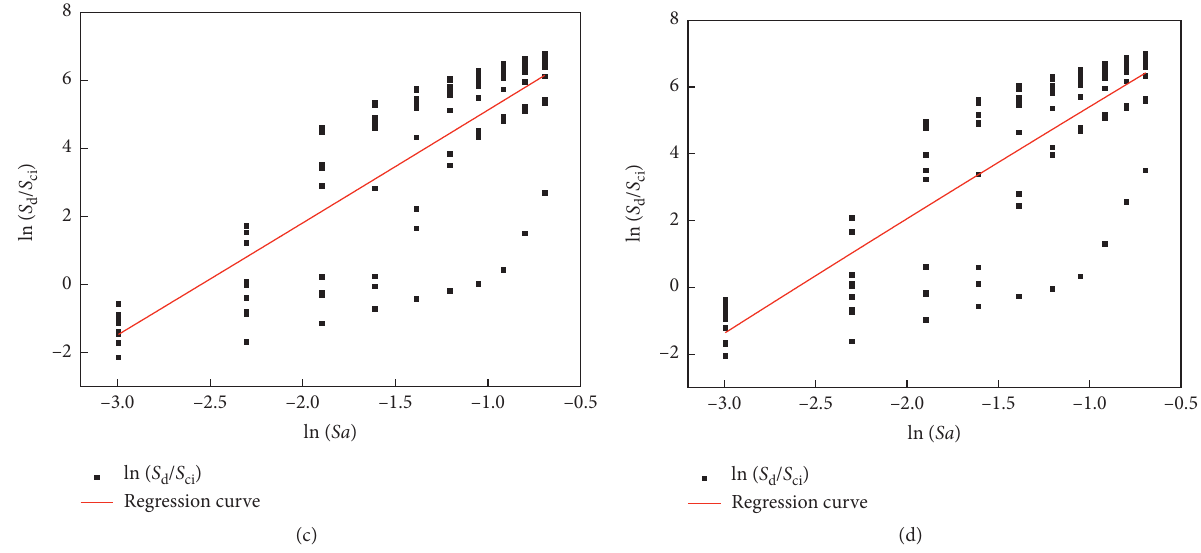
Figure 7: The regression curves of pier 1 under longitudinal seismic actions. (a) Section 1A. (b) Section 1B. (c) Section 1C. (d) Section 1D.